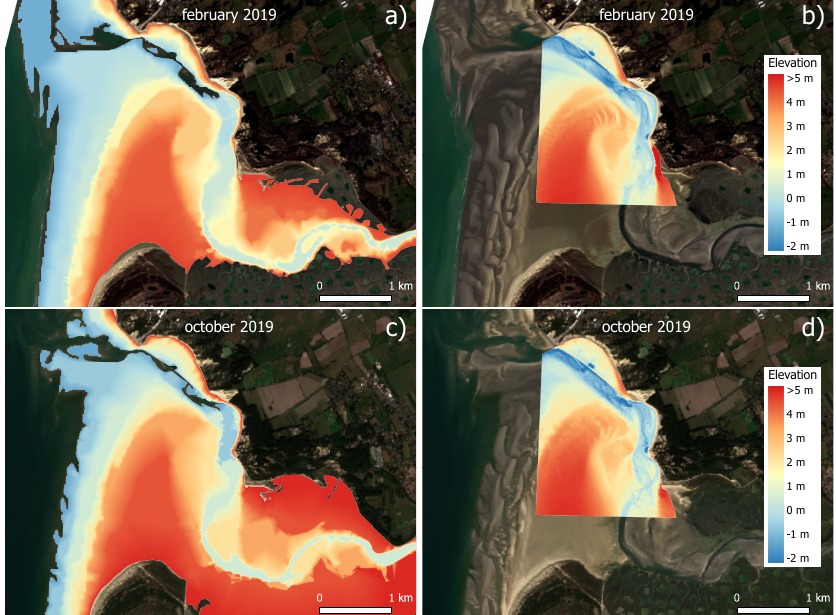
Figure 7. ( a ) DEM constructed using the waterline method, compared to observations ( b ) made in February 2019. ( c , d ) The same for the October 2019 period. Background: Sentinel-2 imagery.